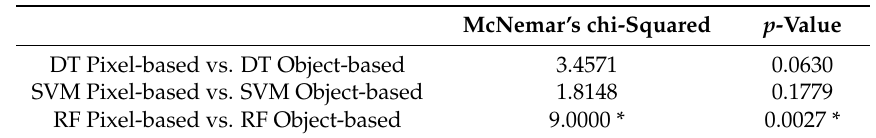
Table 3. Statistically significant comparison between pixel-based and object-based classifications when using the same machine learning algorithm.